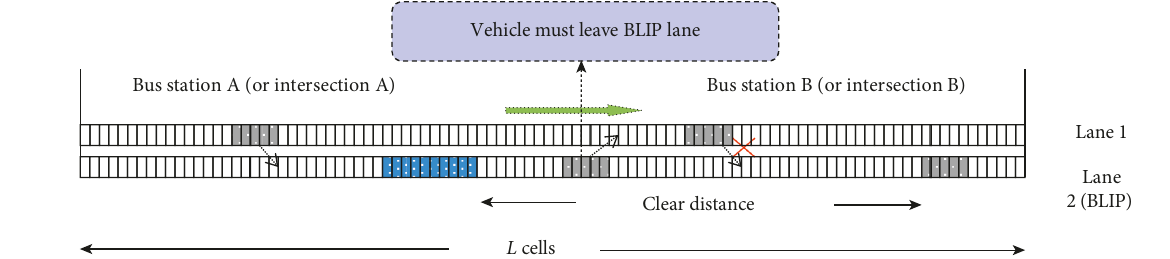
Figure 1: Diagram of double-lane traffic using BLIP. Table 1: Summary of the variables and parameters used in the model definition. Variables and